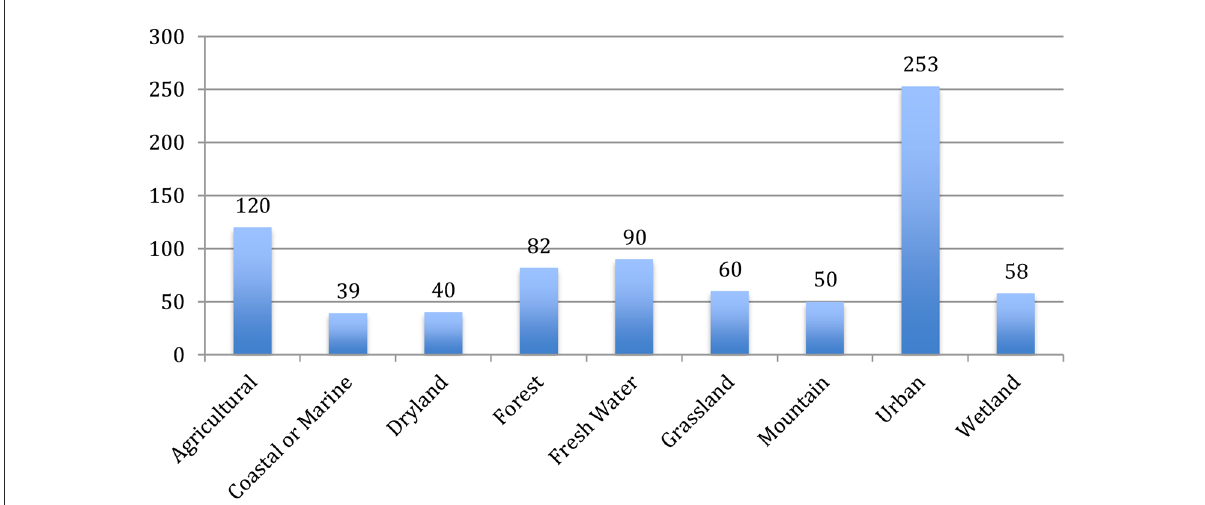
FIGURE11 RCE projects by ecosystem setting during the GAP (2015–2019). n > 479, as RCEs were able to tag more than one ecosystem if the RCE project incorporated more than one. For example, an RCE project worked with training school students about sustainable food supply in an urban setting, it also may have worked with training farmers in an agricultural setting, and the project would have two tags for this variable.